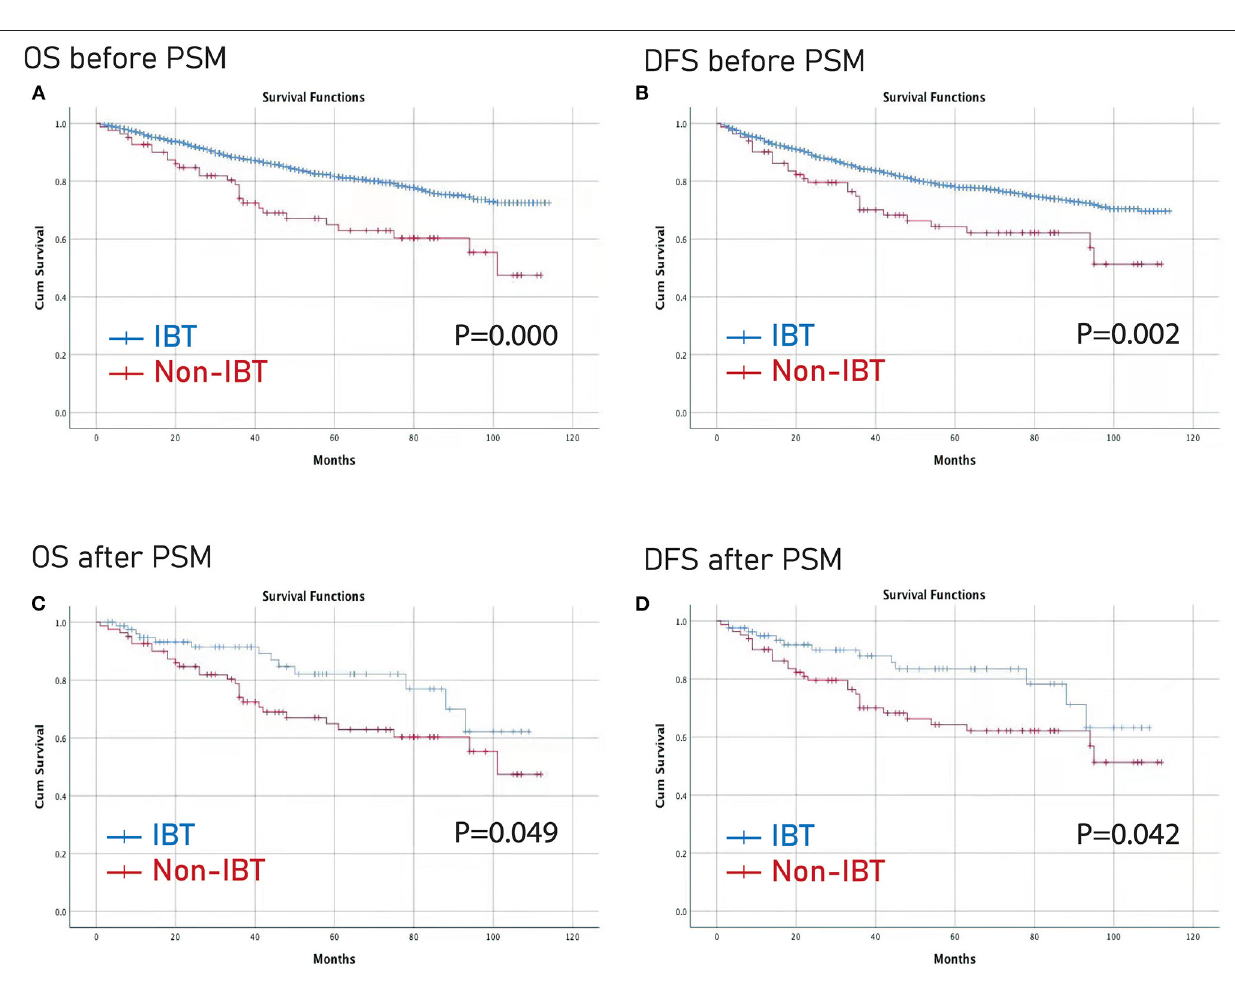
Frontiers in Surgery |